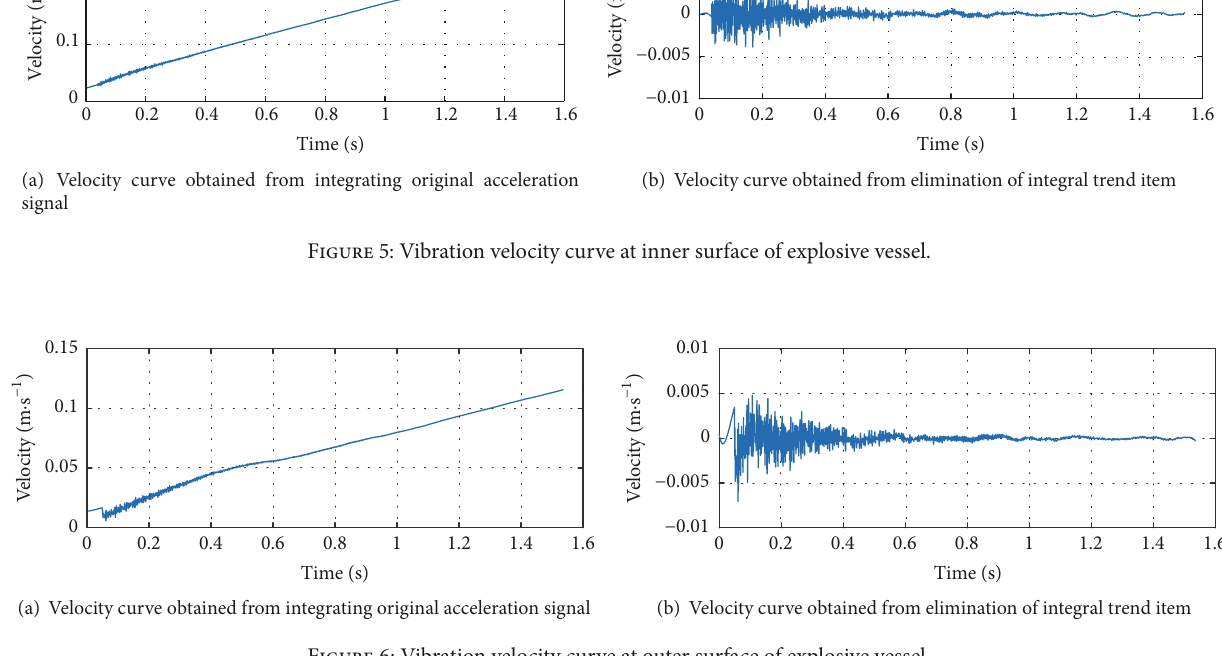
Figure 6: Vibration velocity curve at outer surface of explosive